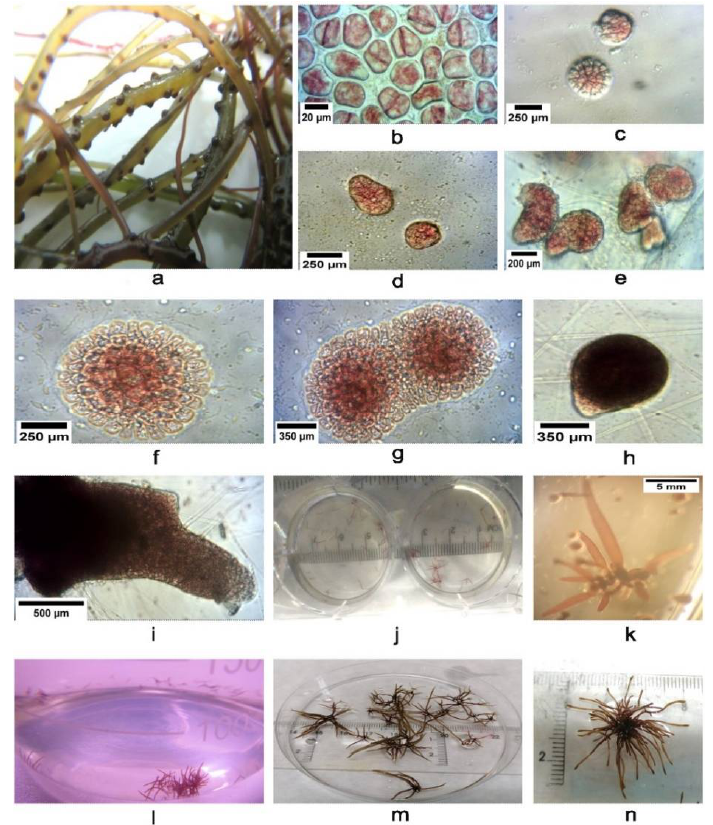
Figure 3. Gracilaria gracilis. ( a ) Cystocarps (2n) on female gametophyte (n). ( b ) Carpospores on day 2, 24 h after sporulation, first cell division is observed in some of them. ( c ) Beginning of basal disc on Miquel A + B medium, after 7 days of culture. ( d ) Beginning of frond growth in Miquel A + B after 20 days of culture. ( e ) Fronds not developed at 27 days of culture in Miquel A + B medium. ( f ) Basal disc developed in ES medium after 12 days of culture. ( g ) Fusion of basal disc in some individuals in ES medium after 12 days of culture. ( h ) Beginning of frond growth in ES medium after 20 days of culture. ( i ) Prominent and bifurcate fronds in ES medium after 27 days of culture. ( j ) Developed thalli after 40 days of culture. ( k ) Developed and fused thalli in ES medium after 60 days of culture in Petris dishes. ( l ) Start of culture in 250 mL erlemeyer after 176 days of culture. ( m ) Thalli developed with a weight of 0.200 g from a 5 L Erlenmeyer flask after 228 days of culture. These thalli were transferred to a 10 L aquarium to estimate the growth rate in the laboratory. ( n ) Individual with 250